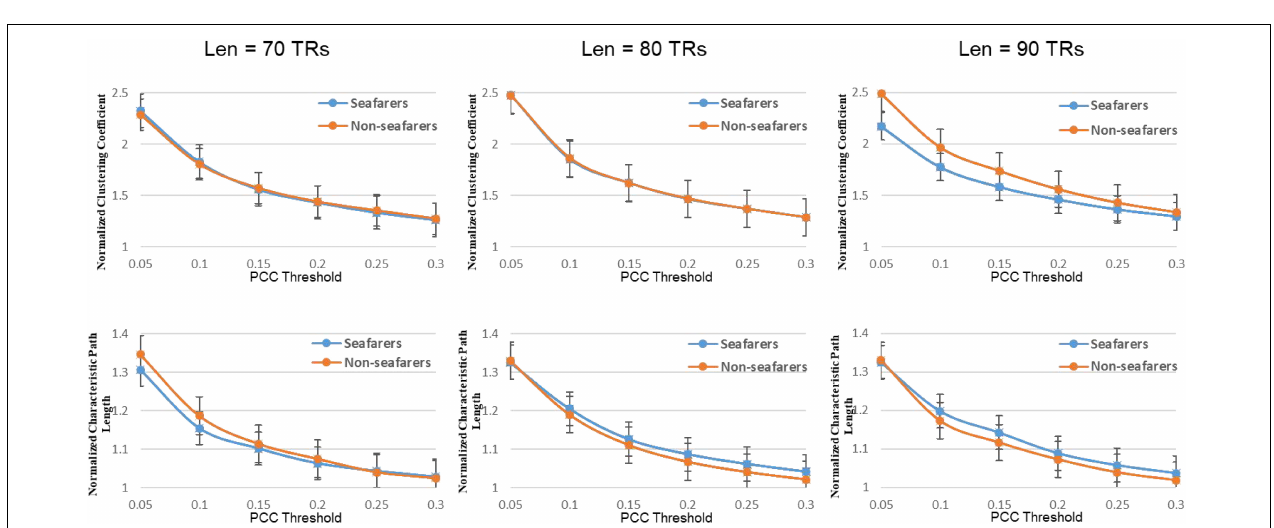
FIGURE 7 | The average normalized path length and average normalized clustering coefficient of the seafarers and non-seafarers based on brain entropy time series under different window lengths and different thresholds.